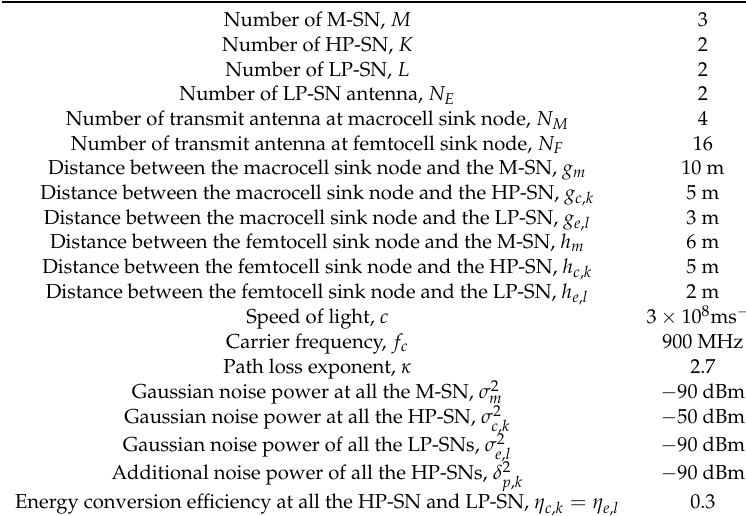
Table 2. System Simulation